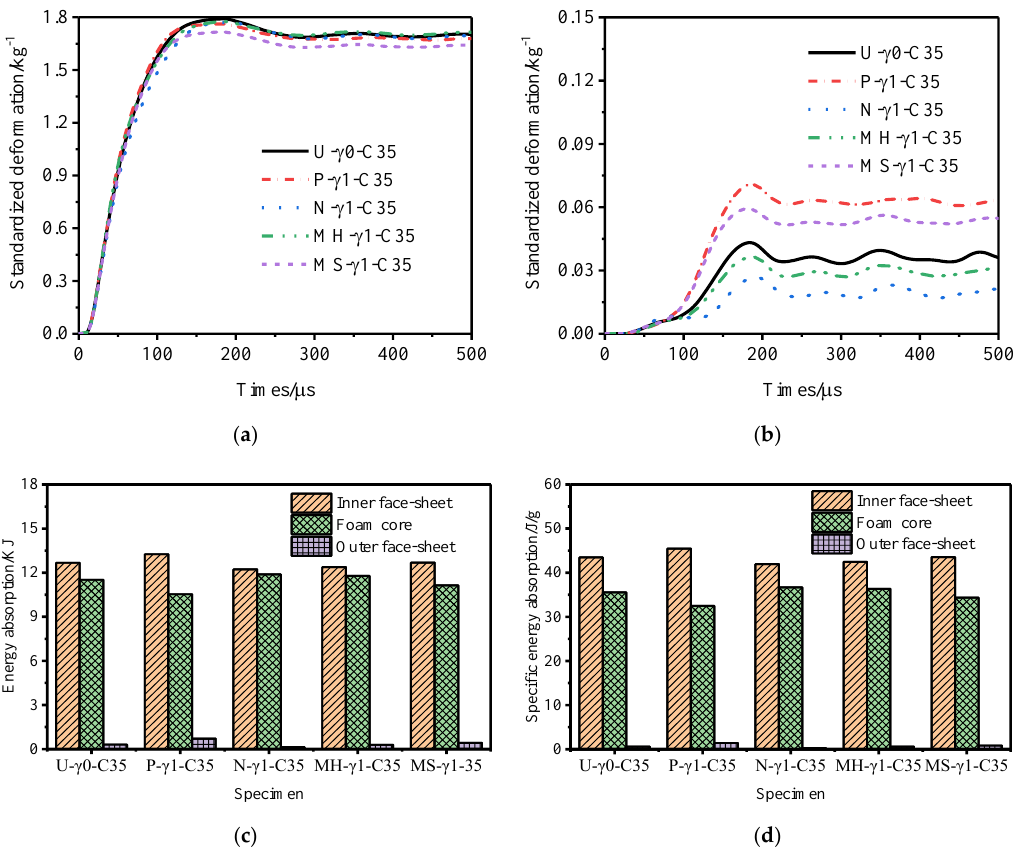
sandwich tube structure when the core thicknesses were 35 mm and 25 mm. When the core thickness was 30 mm, the deformation curves of the inner and outer tubes of the sandwich tube and the total energy absorption and specific energy absorption of the sandwich tube structure are shown in Figure 14. With an increase in the core thickness, the deformation of the inner tube of the five kinds of aluminum foam sandwich tubes gradually increased but the deformation of the outer tube significantly decreased. Be- cause the N-type sandwich tube has the best anti-explosion performance, here is an ex- ample of the N-type sandwich tube. When the core thickness increased from 25 mm to 30 mm, the deformation of the inner tube increased by 2.58% but the deformation of the outer tube decreased by 55.65%. When the core thickness increased from 30 mm to 35 mm, the deformation of the inner tube increased by 7.12% but the deformation of the outer tube decreased by 73.02% (a significant decrease). Figure 23 shows the deformation of the outer tubes of sandwich tubes with different core thicknesses. Figure 20. Deformation diagrams of sandwich tubes with different core thicknesses.